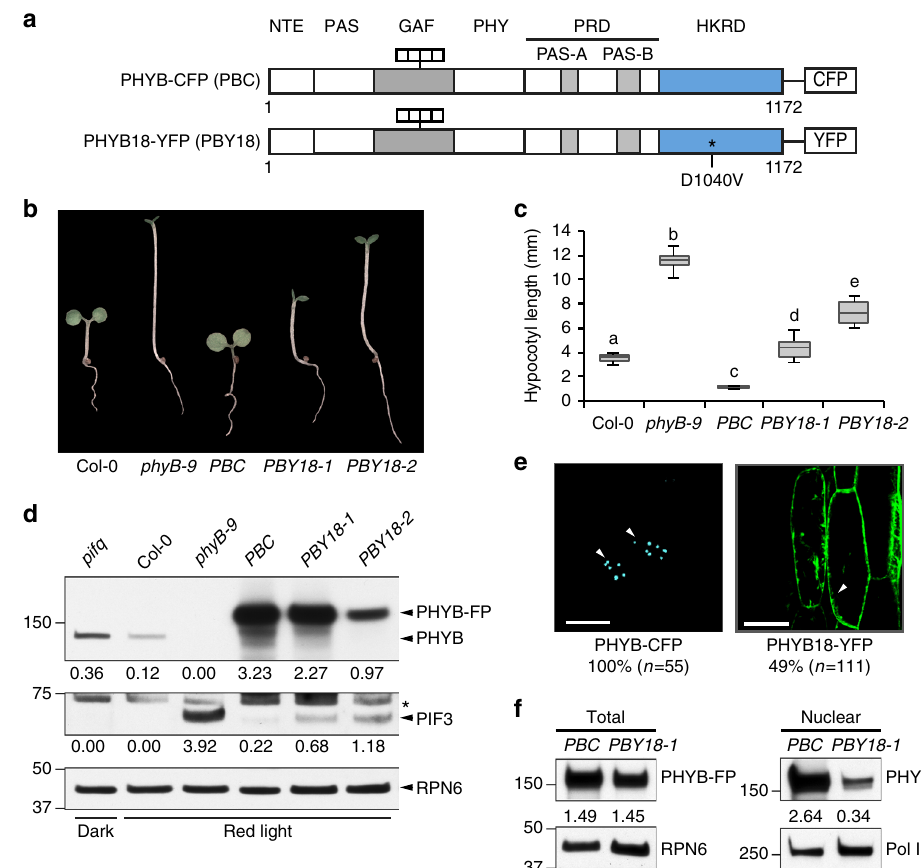
Fig. 1 phyB-18 impairs PHYB nuclear accumulation and PIF3 degradation. a Schematic illustration of the domain structures of PHYB-CFP (PBC) and PHYB18-YFP (PBY18). The phyB-18 mutant carries a D1040V mutation in the HKRD. b Representative images of 4-day-old Col-0, phyB-9 , PBC , PBY18-1 , PBY18-2 seedlings grown in 10 μ mol m − 2 s − 1 R light. c Box and whisker plots of hypocotyl length measurements of the seedlings shown in b . The boxes represent from 25th to 75th percentile; the bars equal to the median values. Samples with different letters exhibit statistically signi fi cant differences in hypocotyl length (ANOVA, Tukey ’ s HSD, P < 0.01, n > 40). d Immunoblots showing the protein levels of PHYB, PHYB-FP and PIF3 in the indicated lines grown either in the dark or 10 μ mol m − 2 s − 1 R light. RPN6 was used as a loading control. The relative levels of PHYB, PHYB-FP or PIF3 were normalized to the corresponding levels of RPN6 and are shown below each lane. The asterisk indicates nonspeci fi c bands. e Confocal images showing the